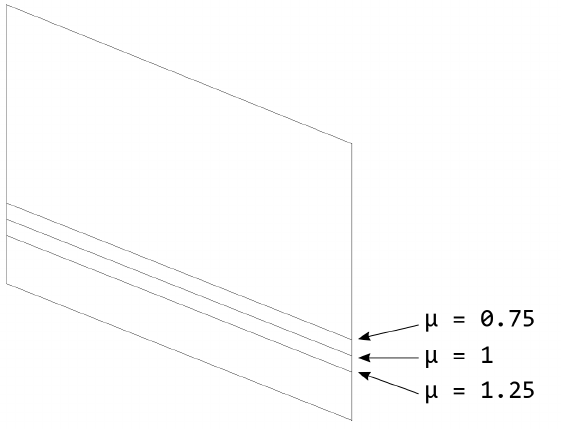
Figure 3. Wing section with control surface showing chord lengths for the different µ